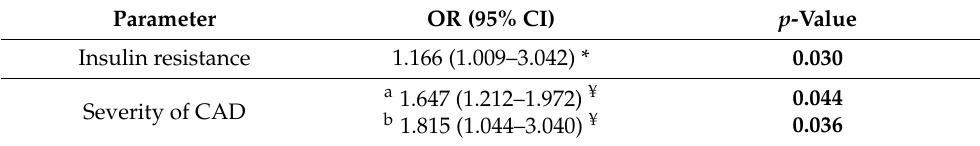
Table 5. Association of IR and the severity of CAD in correlation with RBP-4 levels.